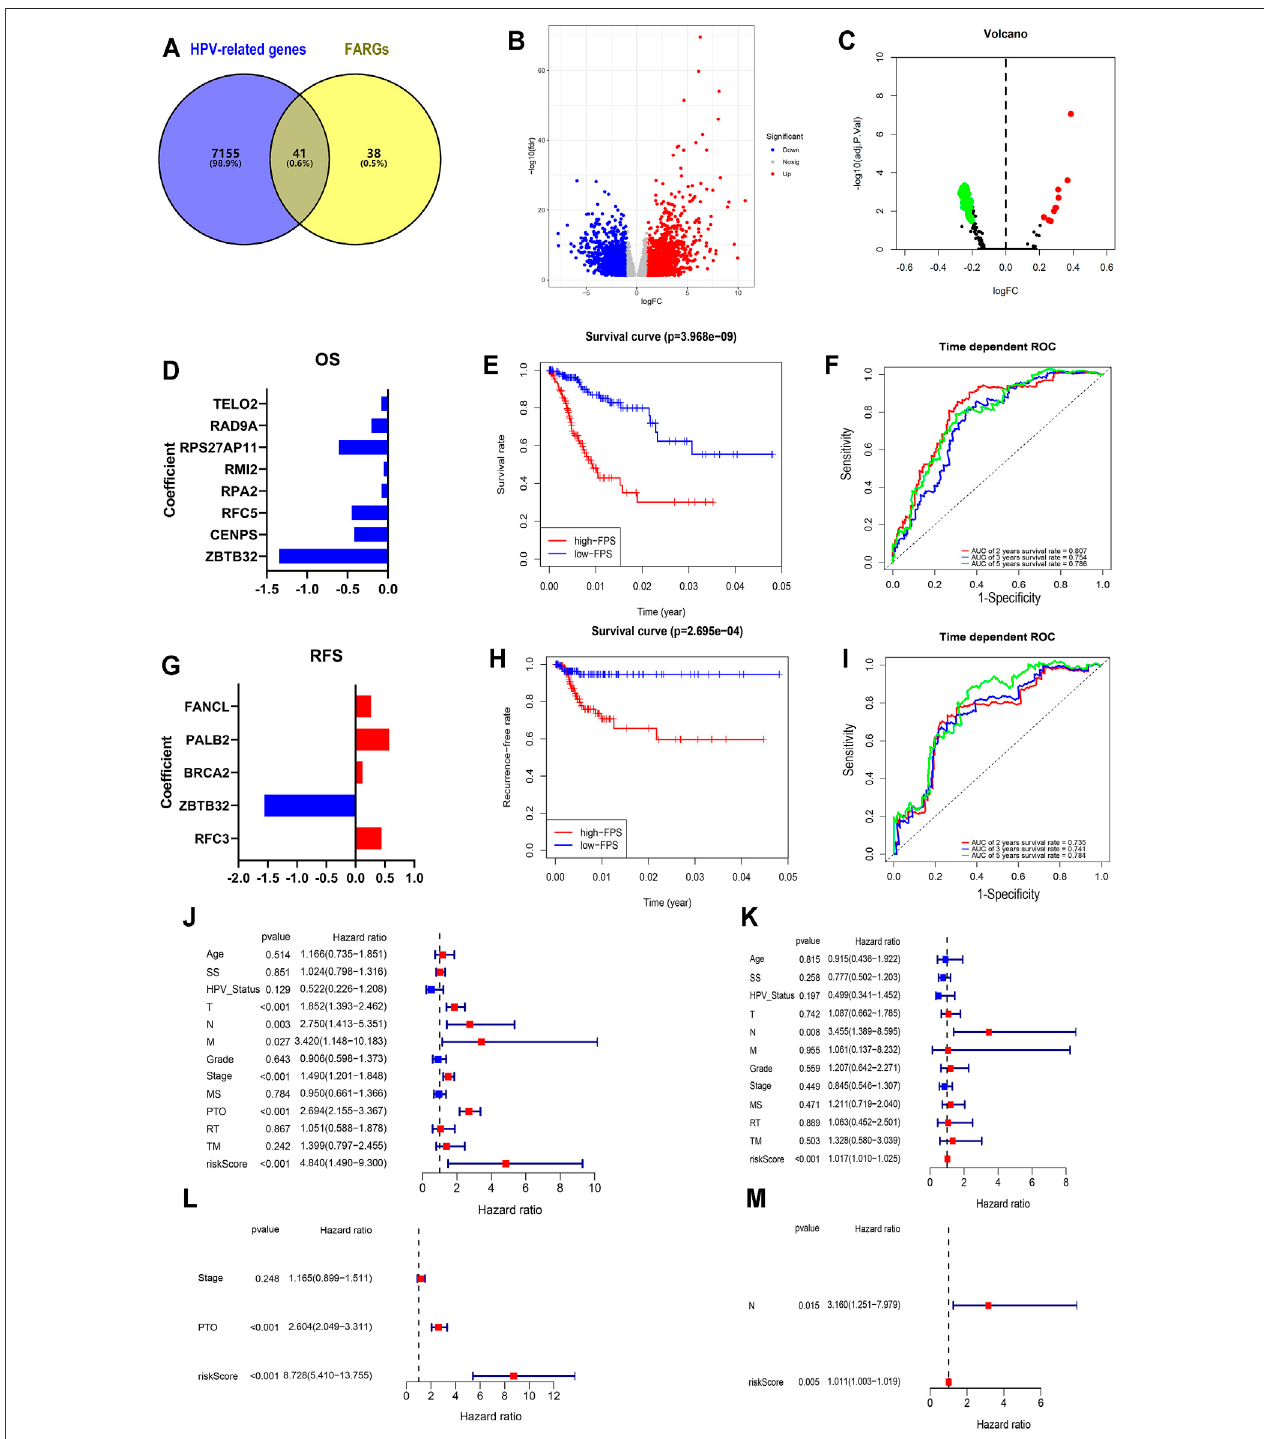
FIGURE2| EstablishmentandvalidationofFPSinCC. (A) TheoverlapofHPV-relatedgenesandFARGs. (B) VolcanoplotofdifferentgenesinHPV+( n (cid:1) 286)and HPV − ( n (cid:1) 19) subgroups of TCGA CESC patients. (C) GSVA analyses of FARGs in CESC. (D) The fi ltered variables from OS-LASSO model and coef fi cients. (E) The Kaplan-Meier survival curves for CC patients with high and low FPS. (F) ROC curves described the predictive ability of OS-LASSO model for 2-, 3-, and 5-years survival probabilities. (G) The fi ltered variables from RFS-LASSO model and coef fi cients. (H) The KM analyses for CC patients with high and low FPS. (I) ROC curves described the predictive ability of RFS-LASSO model for 2-, 3-, and 5-years survival probabilities. (J) The correlation between clinicopathological parameters included